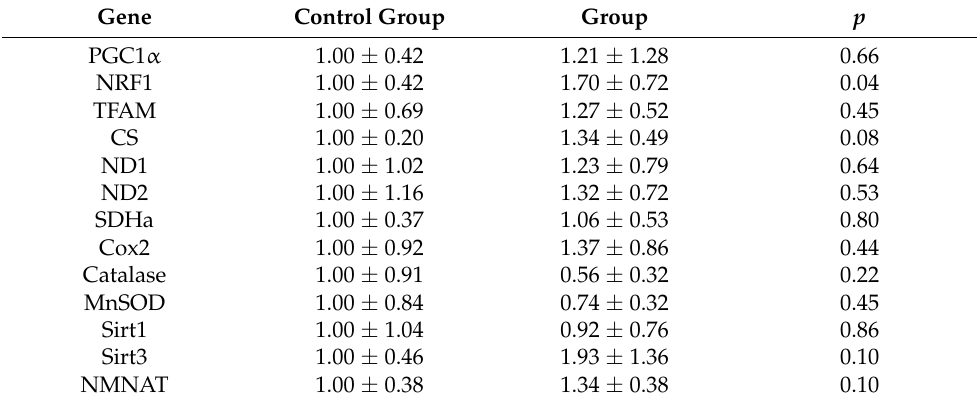
Table 3. mRNA levels of genes involved in mitochondrial biogenesis, anti-oxidant defences and NAD metabolism. The mRNA levels were determined by real-time quantitative RT-PCR and expressed relative to the value of GAPDH, an internal control. Data are presented as the mean ± SD, n = 8. Gene Control Group Group p PGC1 α 1.00 ± 0.42 1.21 ± 1.28 0.66